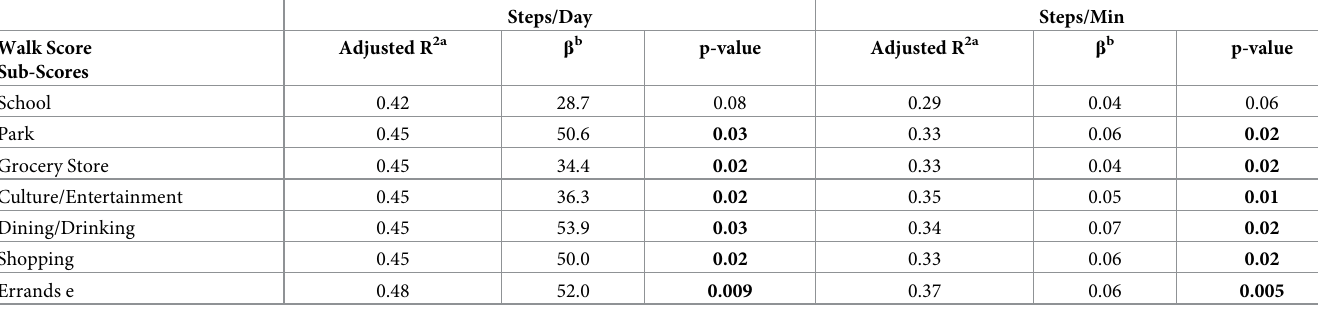
Table 3. Association of Walk Score sub-scores with step outcomes.